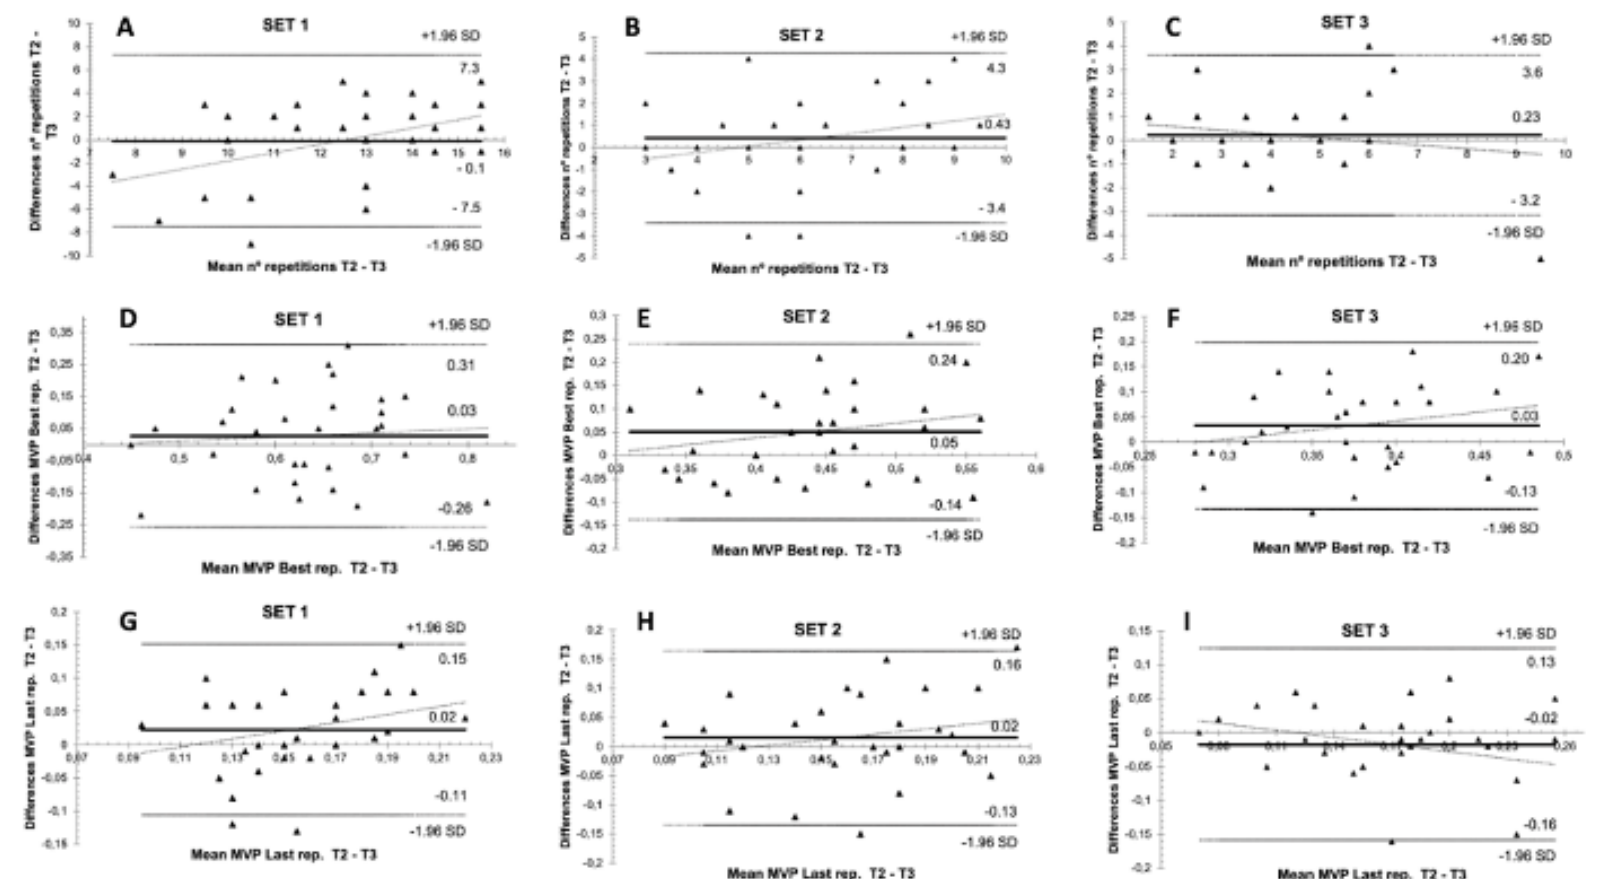
Figure 6. The Bland–Altman plots in the intrasubject variability [test (T2)–retest (T3)] assessment for the three sets of the bench press exercise protocol of the total group of participants ( n = 30): ( A – C ) number of repetitions, ( D – F ) Mean propulsive velocity attained at the best repetition, ( G – I ) Mean propulsive velocity attained at the last repetition (MPV Last).